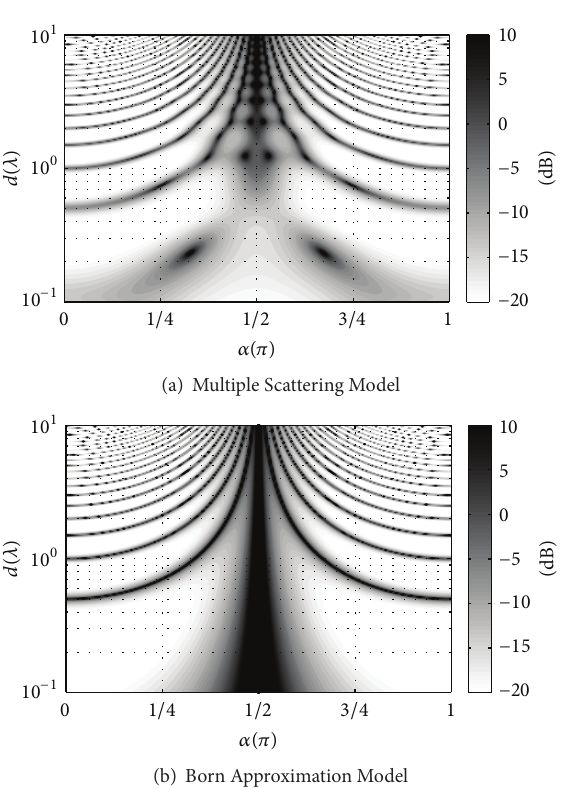
Figure 4: Plots of CRB (𝑑) as a function of incidence angle 𝛼 and scatterer separation 𝑑 , normalized by 𝜎 2 , for the case where 𝑑 𝑐 is known. The observation angle 𝛽 = 𝜋 − 𝛼 and 𝜏 1 = 1 = 𝜏 2 .